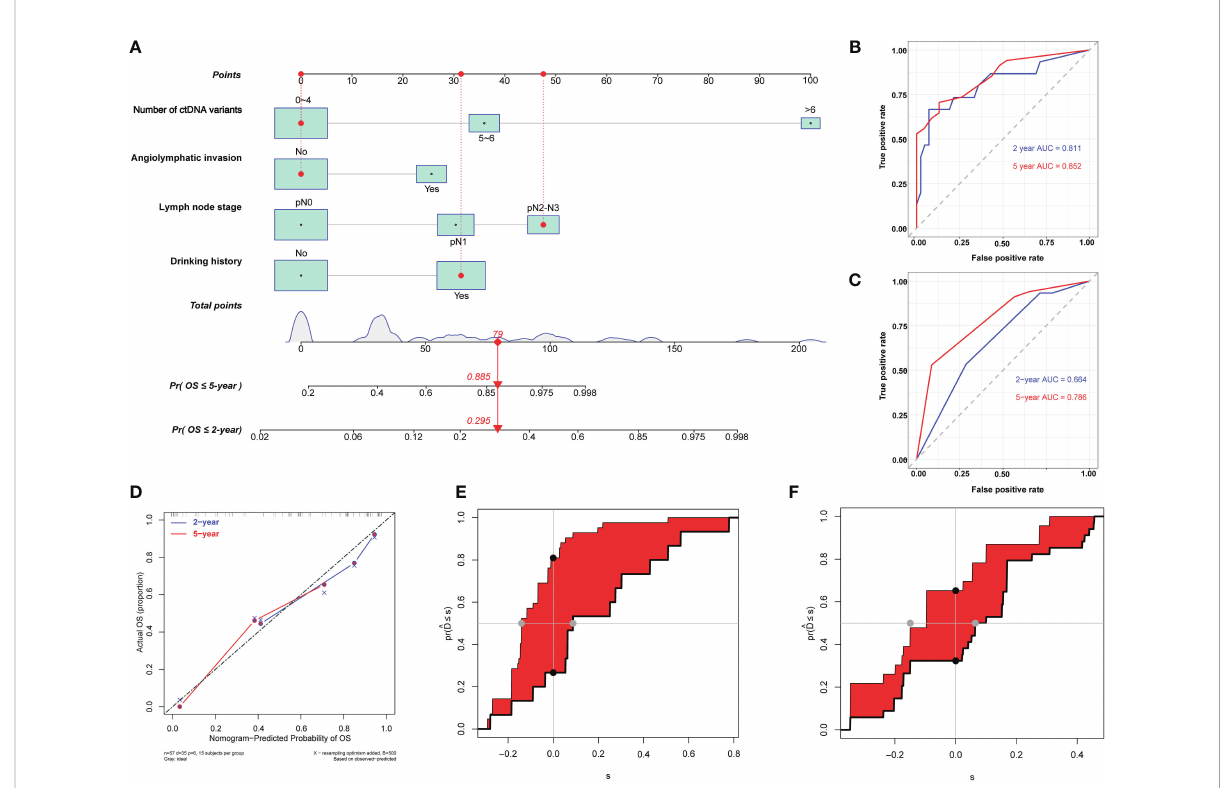
FIGURE 6 Development and evaluation of nomogram for overall survival prediction in patients with esophageal squamous cell carcinoma (ESCC). (A) Nomogram based on preoperative circulating tumor DNA features for overall survival (OS) in patients with resectable ESCC. The prediction result of patient no. 15 is listed as an example. Each subgroup within the variables was assigned a score. To determine the score of each independent prognostic factor, a vertical line was drawn from each factor axis to the “ Points ” scale; the position of the red dot on the “ Points ” axis indicates the score of this factor (with a drinking history, score = 31; no angiolymphatic invasion, score = 0; pN2 LNS, score =48; and three variants of ctDNA, score = 0). The predicted probability of OS can be found vertically below the location of the Total Points. The total scores for all four factors are summed to get the “ Total points ” value (31 + 0+48+0 = 79, which is indicated as a red diamond on the “ Total points ” scale). The red arrow on the “ Pr ” axis indicates the recurrence probability in the corresponding years (the recurrence probability within two years was 0.295, and the recurrence probability within fi ve years was 0.885). (B) Receiving operating characteristic (ROC) curves of the nomogram for predicting 2-year and 5-year OS. (C) ROC curves of the TNM staging system for predicting 2-year and 5-year OS. (D) Agreement between the observed and predicted proportions of OS after surgery for ESCC patients. (E) Integrated discrimination improvement (IDI) between the developed nomogram and TNM staging system for predicting 2-year OS. (F) IDI between the developed nomogram and TNM staging system for predicting 5-year